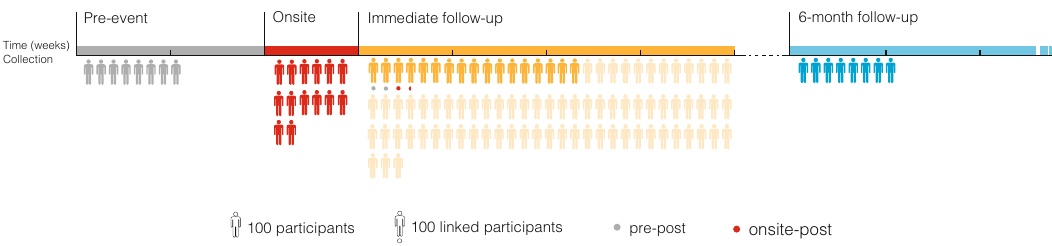
Fig. 1 Stages of data collection. Each icon represents 100 participants. Pre-event participants were recruited via newsletters sent out to all Burning Man attendees 0 – 2 weeks before attendance. Onsite participants were recruited by teams of experimenters hosting a booth with a sign that read “ Play Games